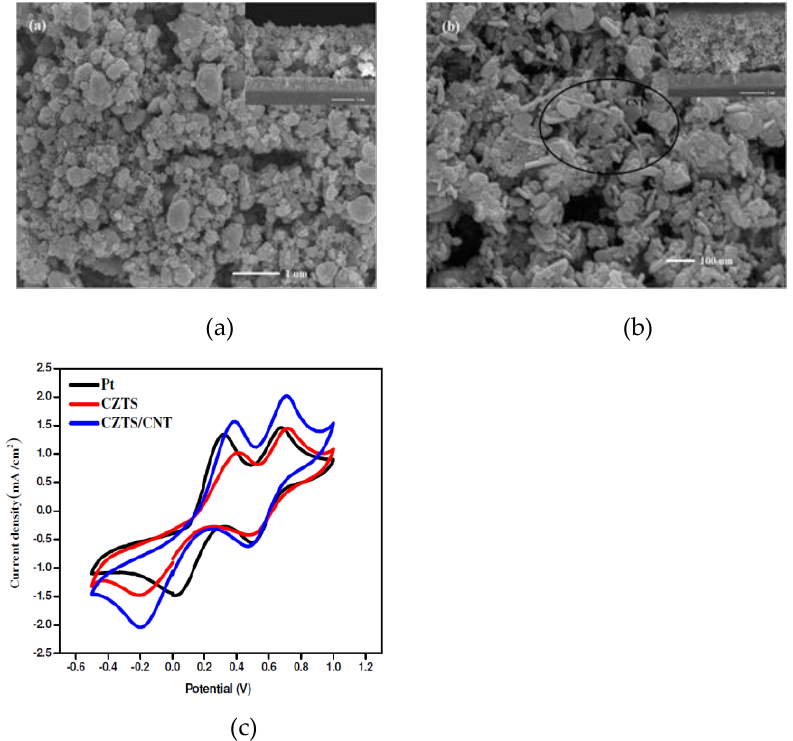
Figure 13. SEM images of ( a ) CZTS nanoparticles, ( b ) CZTS/CNT composite, and ( c ) CV micrograph for the Pt, CZTS, and CZTS/CNT counter electrodes. Reproduced with permission from Reference [55], Elsevier 2016.